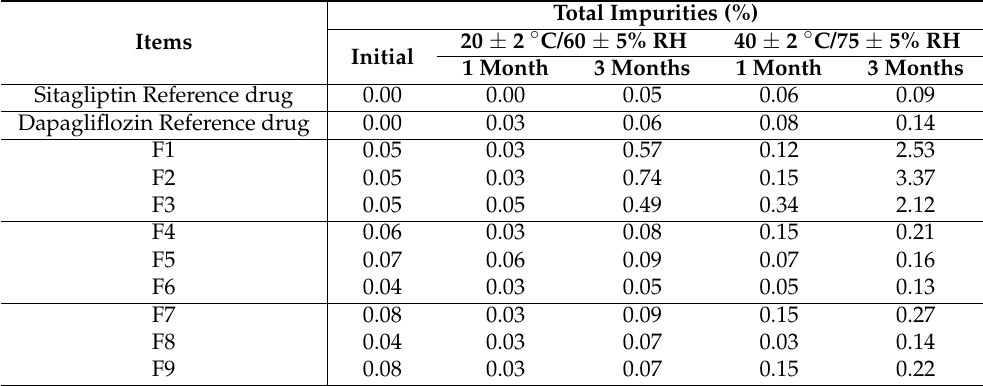
Table 15. Impurity test results of the reference drug and sitagliptin phosphate